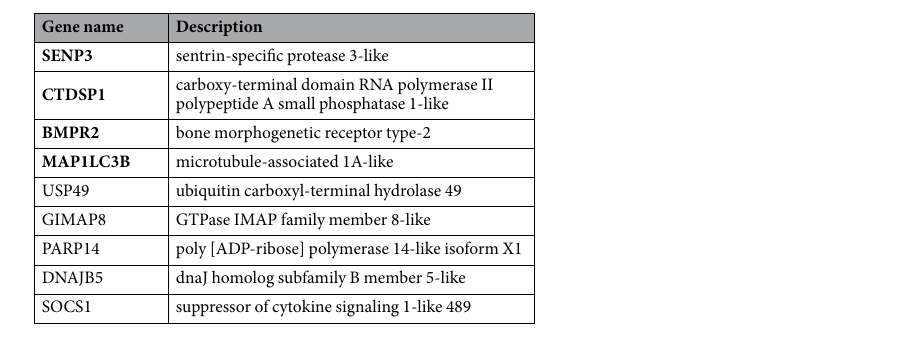
Table 3. Positively selected genes involved in the hypoxia response in C. macropterus (UT populations). Gene names in bold are completely consistent with the 1,351 putative hypoxia-related genes, the others are homologous or